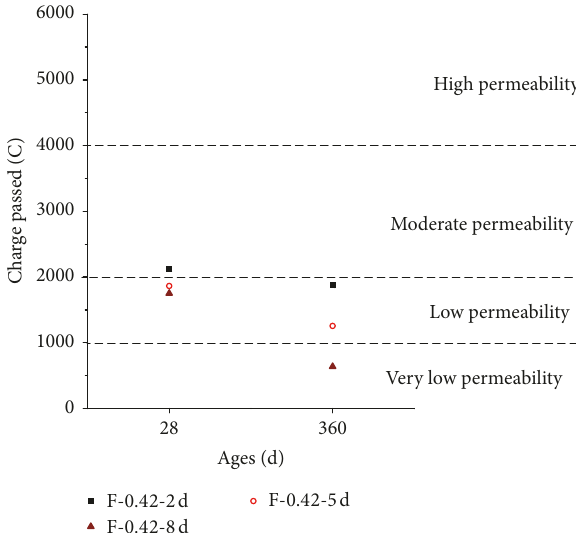
Figure 6: Chloride permeability of plain cement concrete.